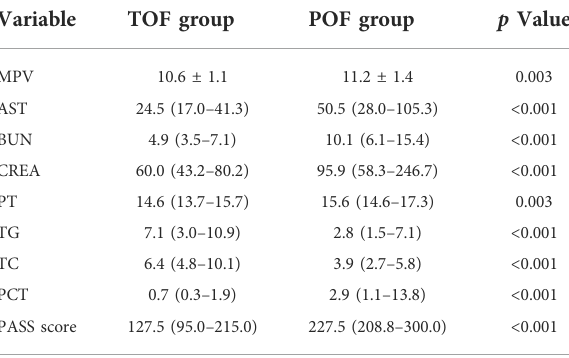
TABLE 2 Univariate analysis of the POF group and TOF